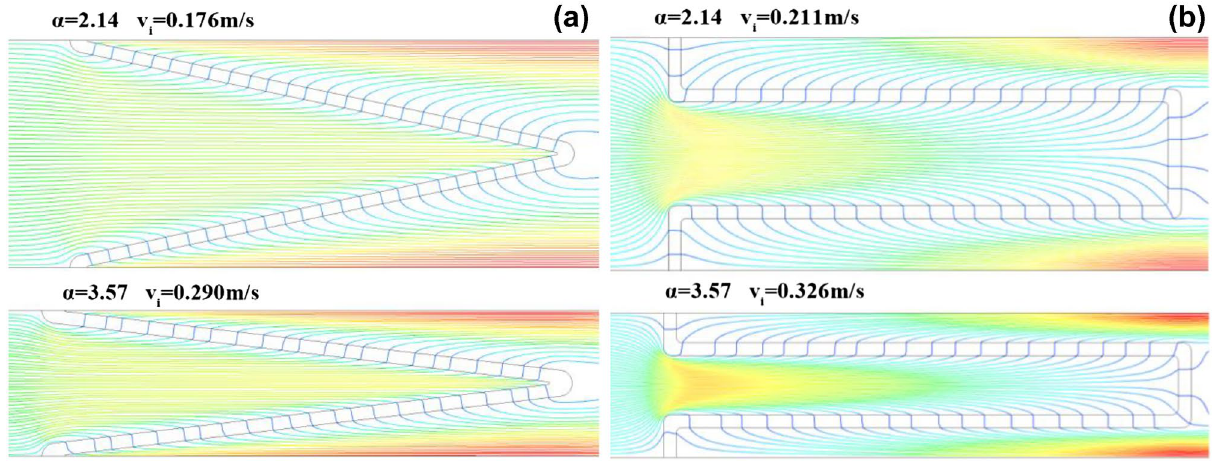
Figure 6. Airflow fields at the filtration velocity of 4